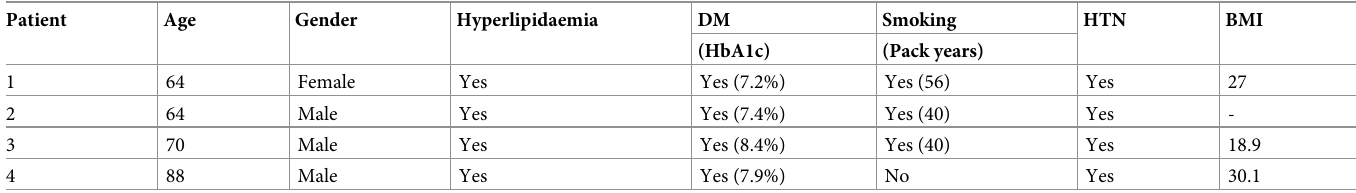
DM: diabetes mellitus type 2. HTN: hypertension.